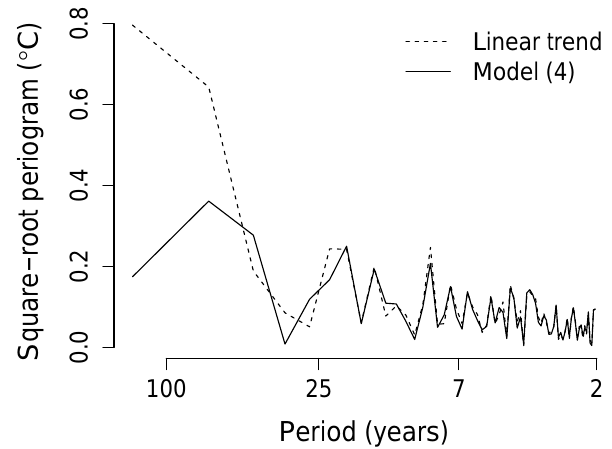
Figure 6. Raw periodograms of residuals from models (2) (dashed) and (4) (solid) fit to the full data record. There is substantially more low-frequency variability in the residuals from the linear trend model than in the residuals from model (4). Misspecified mean models will give a misleading impression of low-frequency vari- ability, and therefore misleading uncertainties associated with the mean